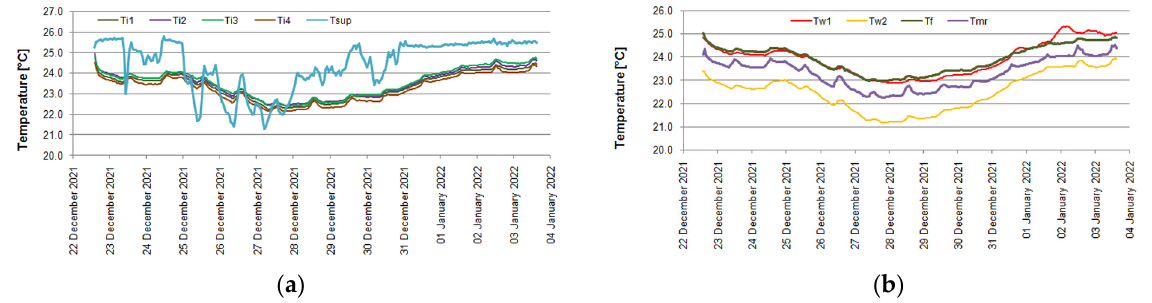
Figure 5. Measurement results: ( a ) Indoor and supplying air temperature; ( b ) Mean radiant, floor, and internal wall temperature.